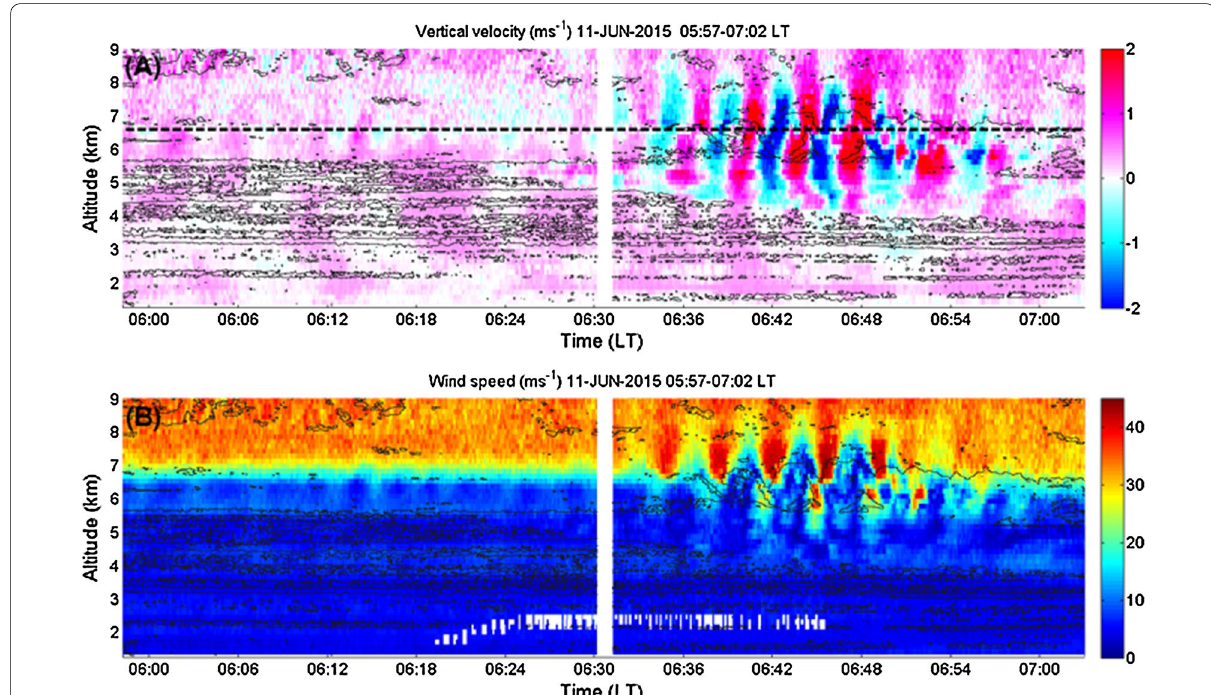
Fig. 4 a Time–height cross section of vertical velocity W ( ms − 1 ) measured by the vertically pointing beam of the MU radar. The horizontal dashed line shows the altitude of the critical level of the KH instability (defined as the altitude where phase shift of W disturbances was observed). b The corresponding time–height cross section of horizontal wind speed ( ms − 1 ) . The black contours show an arbitrary level of radar echo power for delineating the KH billows. The missing data are due to contaminations in the Doppler spectra by a UAV flying near the MU